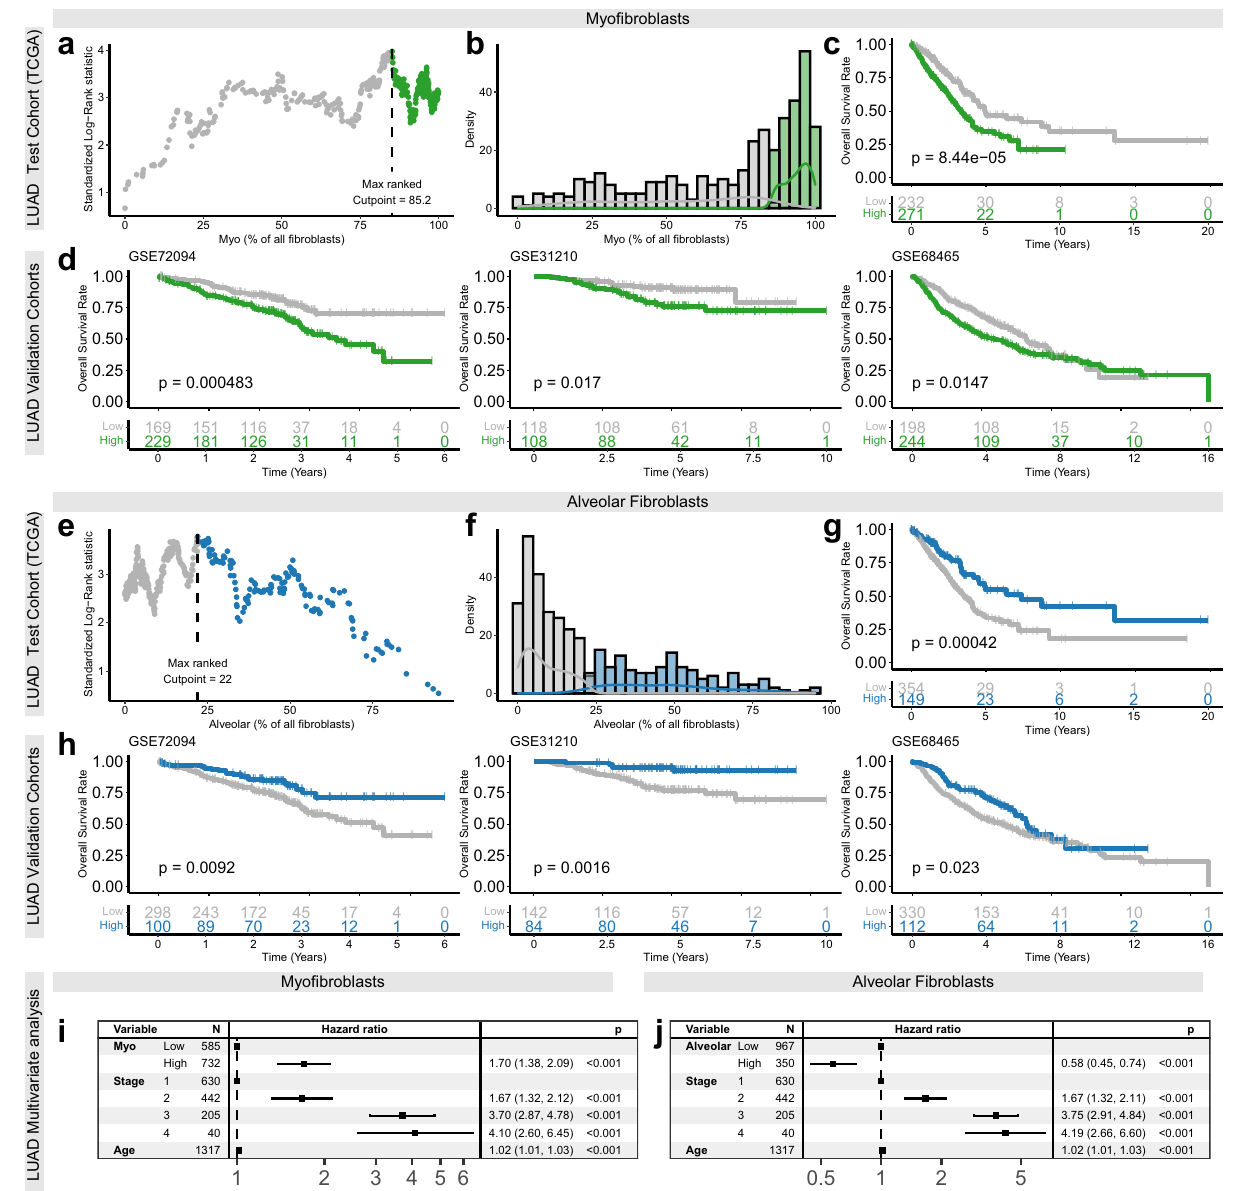
Fig. 6 | CIBERSORTx-mediated digital cytometry shows that myo fi broblasts and alveolar fi broblasts correlatewith overall survivalrates inLUAD. a Scatter plot showing the variation in standardised log-rank survival statistics (correlation with overall survival rates) using different cut-points for dichotomising TCGA- LUAD 25 samples by myo fi broblast abundance. b Density plot showing the dis- tribution of myo fi broblast abundance measurements across TCGA-LUAD 25 sam- ples. c Kaplan – Meier plot showing TCGA-LUAD 25 cohort patient survival rates, strati fi ed by myo fi broblast abundance using the optimal cut-point for dichot- omisation(identi fi edin a ).Statisticalsigni fi cancewasassessedusingalog-ranktest ( n =503). d Kaplan – Meier plots showing the cutpoint de fi ned on TCGA-LUAD cohort (identi fi ed in panel a ) applied to three additional LUAD validation cohorts. Statisticalsigni fi cancewasassessedusingLog-ranktests( n =398[GSE72094 51 ],226 [GSE31210 52 ], 422 [GSE68465 53 ]). e Scatter plot showing the variation in standar- dised log-rank survival statistic (correlation with overall survival rates) using dif- ferent cut-points for dichotomising TCGA-LUAD 25 samples by alveolar fi broblast abundance. f Densityplotshowingthedistributionofalveolar fi broblastabundance measurements across TCGA-LUAD 25 samples. g Kaplan – Meier plot showing TCGA-